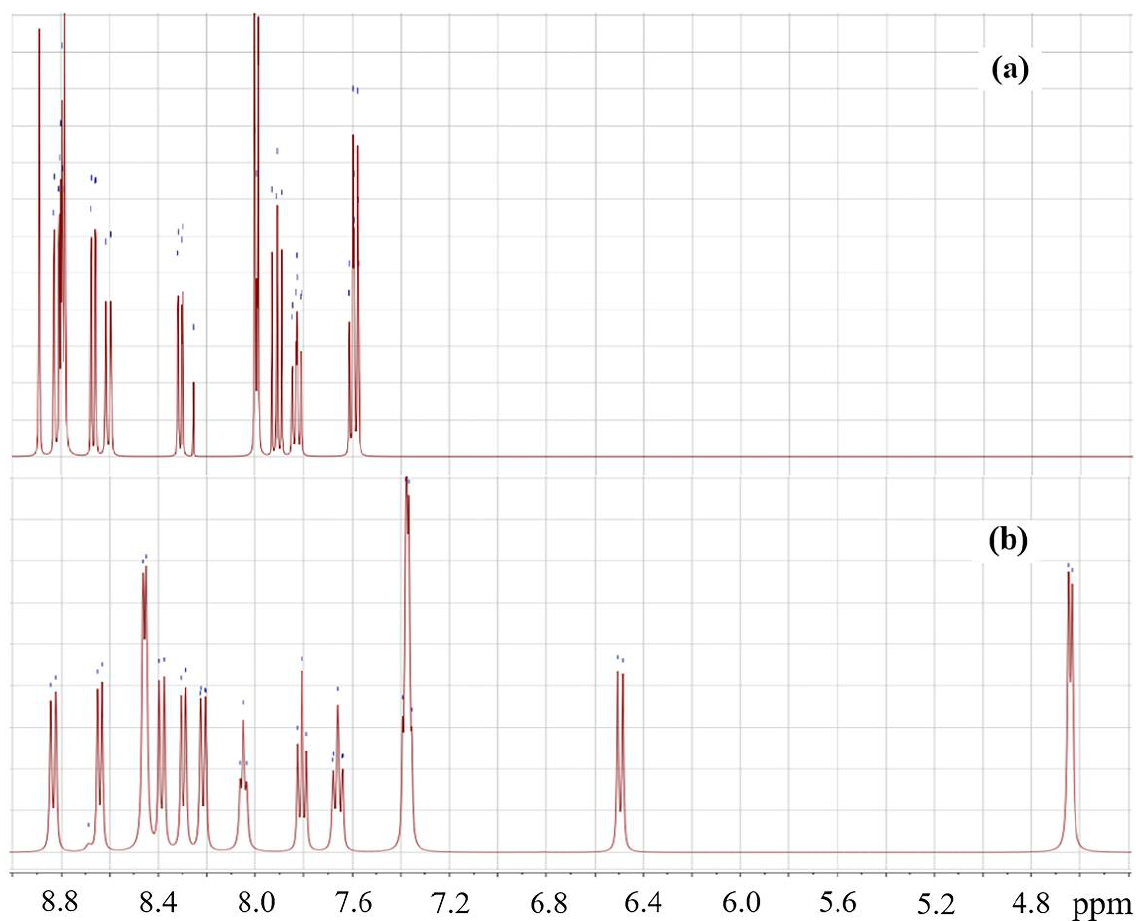
Figure 1. 1 H-NMR spectra of derivatives 2b ( a ) and 3b ( b ) in d6-DMSO solution.